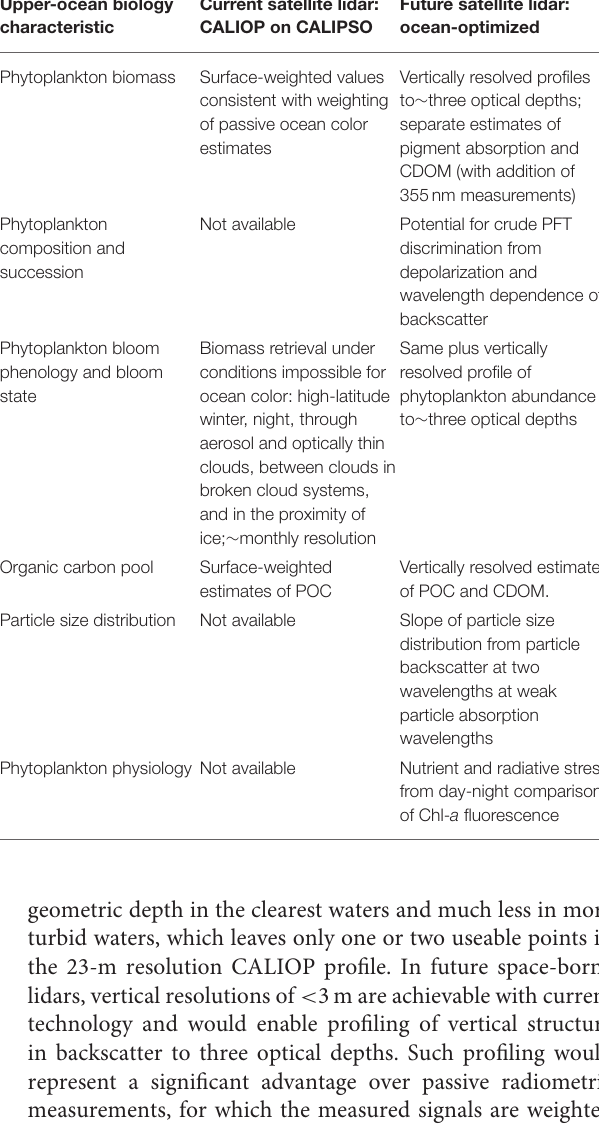
TABLE 1 | Characteristics of upper-ocean biology that can be derived from current and potential future satellite lidar missions Neukermans et al. (2018). Upper-ocean biology